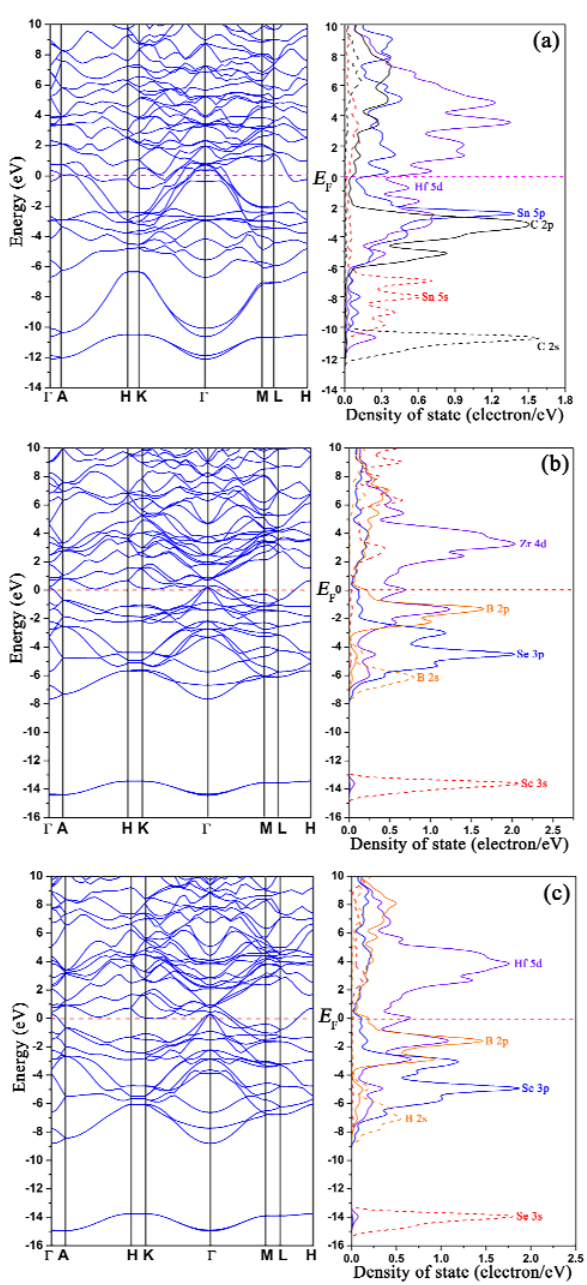
Fig. 2 Band structures and partial density of states of (a) Hf 2 SnC, (b) Zr 2 SeB, and (c) Hf 2